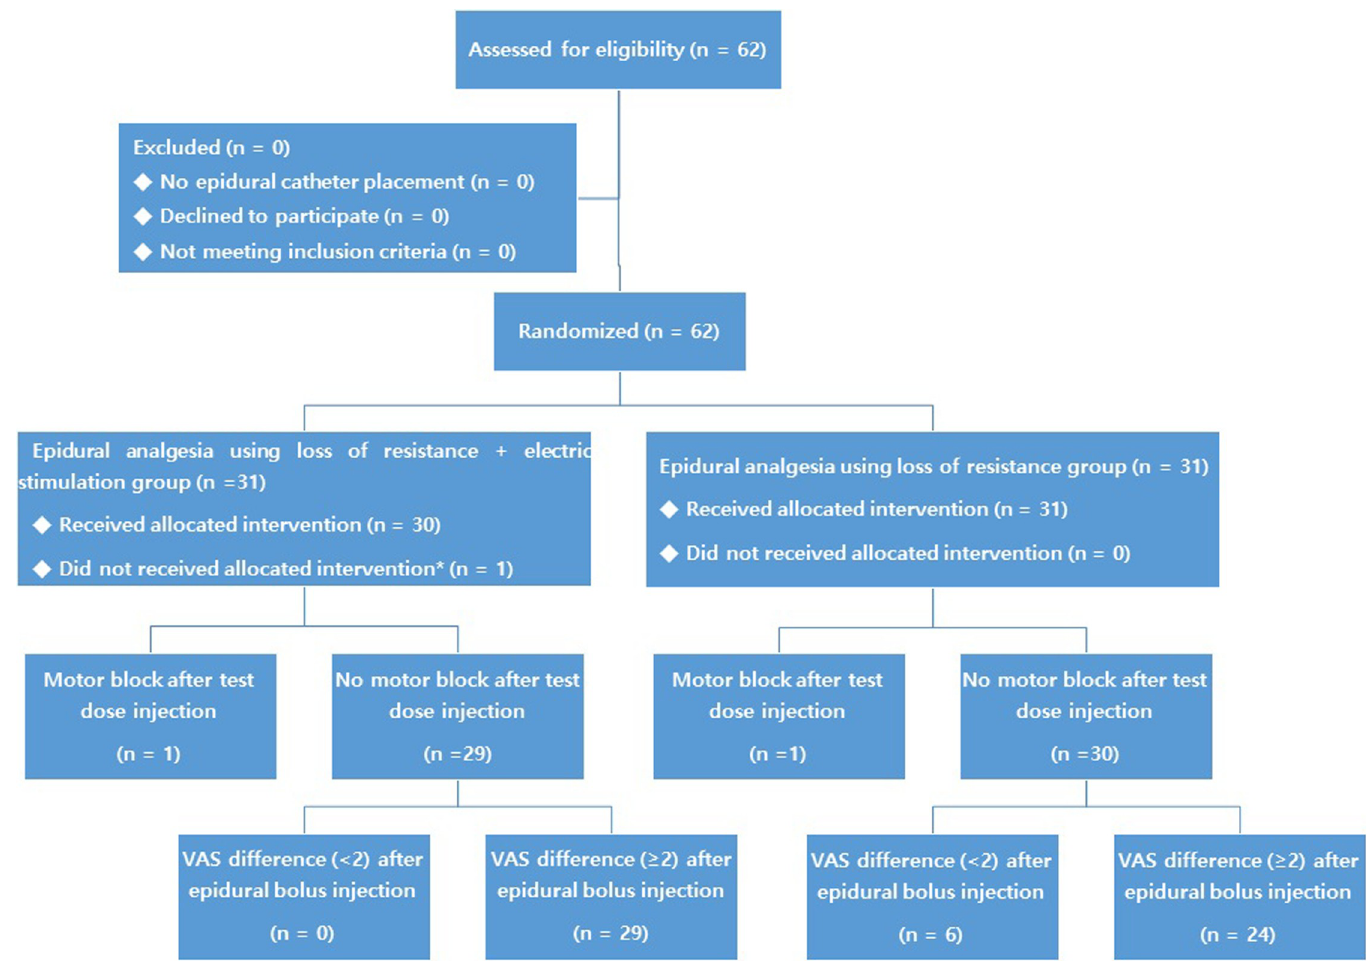
Fig 1. Flow diagram of patients. � Excluded due to dural puncture by Tuohy needle.